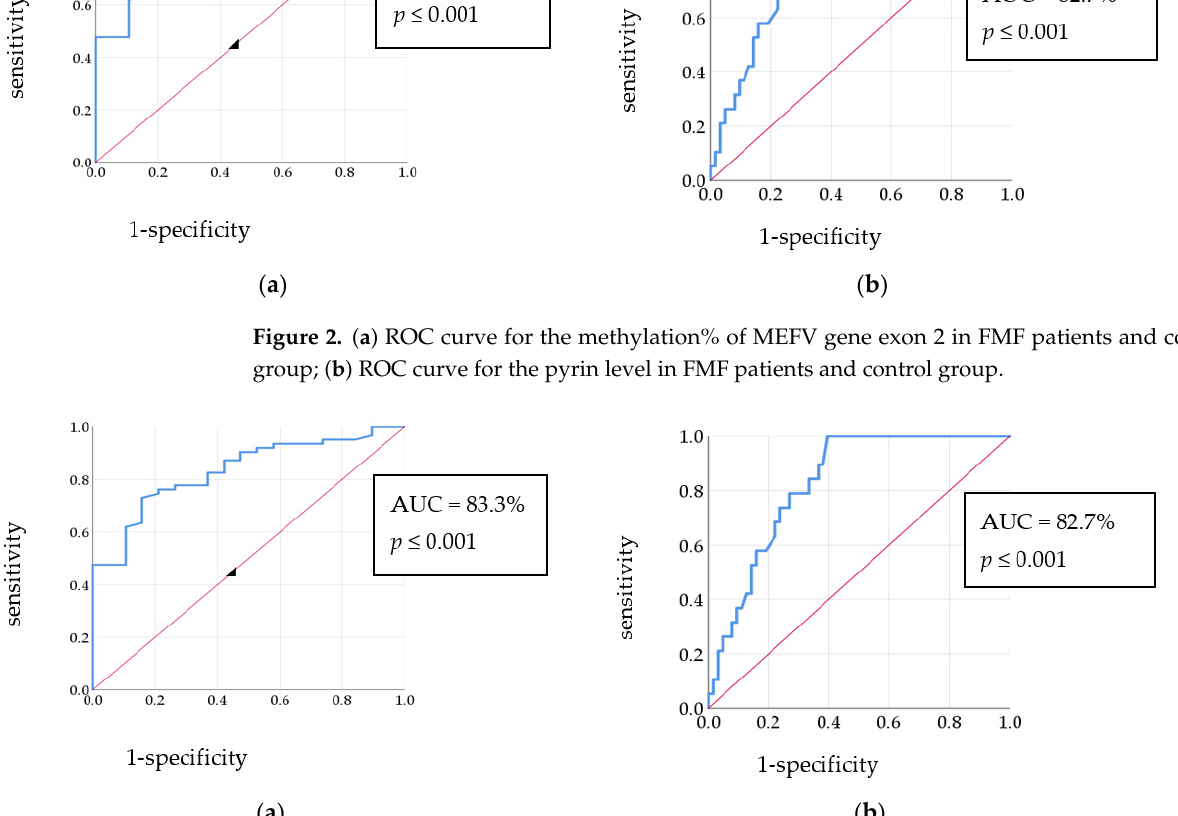
Figure 3. Correlation of the MEFV exon2 methylation% and the pyrin concentration among: ( a ) con ‐ trols; ( b ) FMF patients.